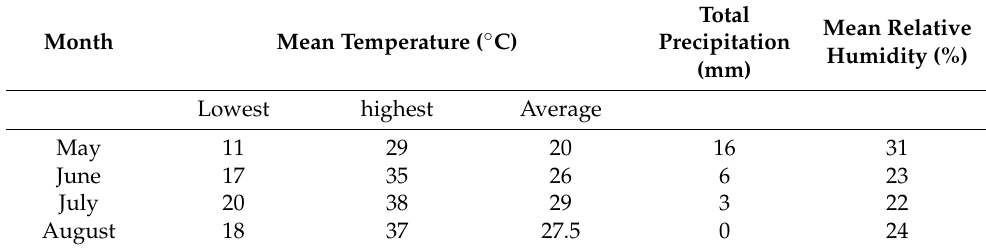
Table 3. Weather data of the location during experiment